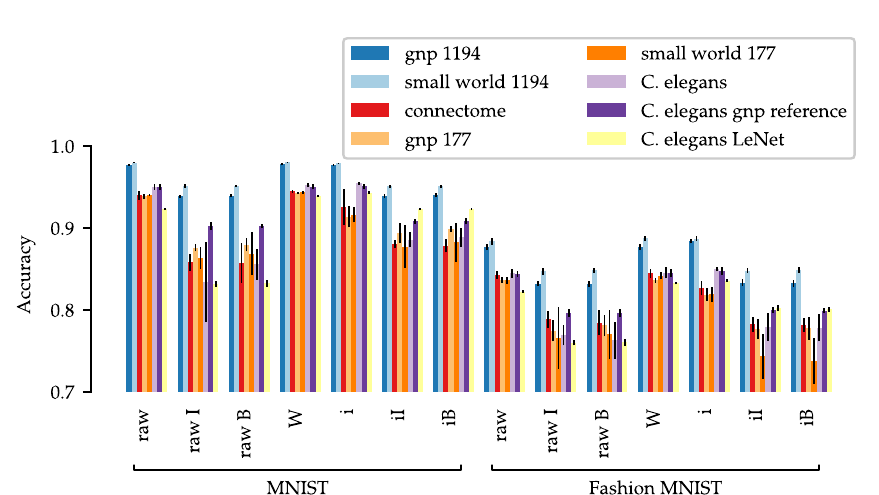
Figure 3. Best accuracy of the recurrent experiments. Error bars show standard deviation over ten independent random iterations. I—iterative pruning, B—bio pruning; W—winning ticket, i—structure